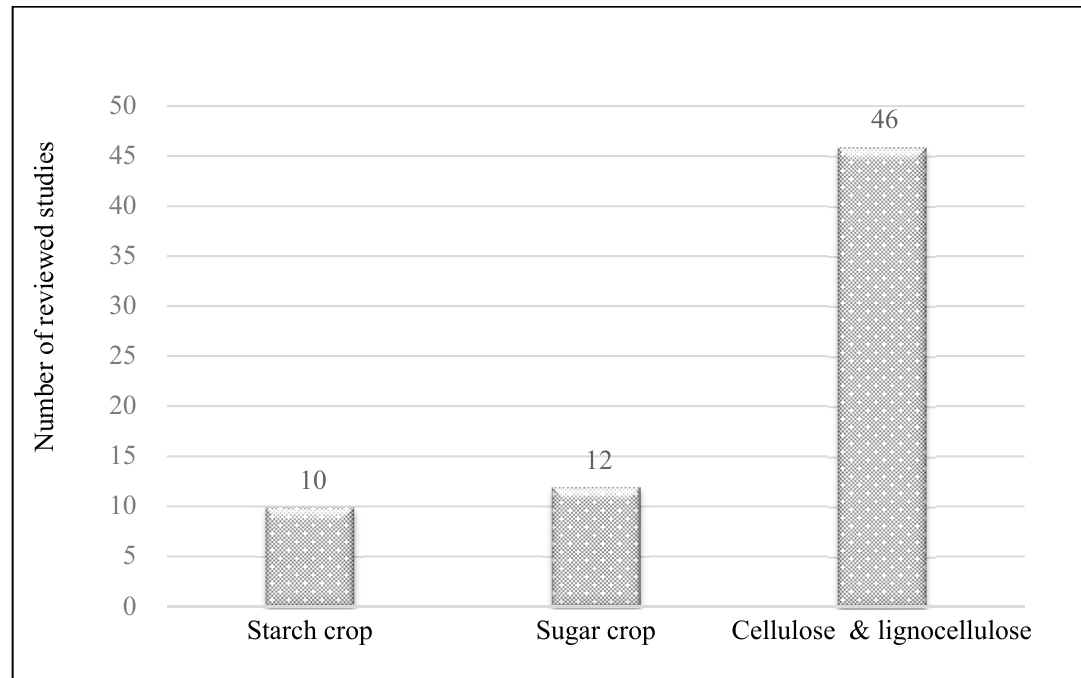
Figure 2. Type of biomass considered by reviewed papers (some of papers studied more than one feedstock).